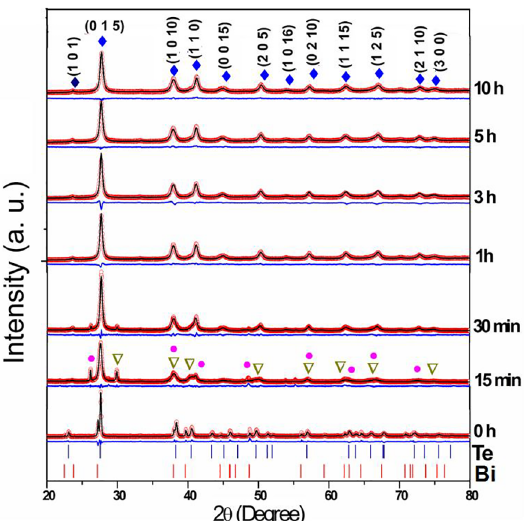
Figure 1. Rietveld output of X-ray powder diffraction patterns of ball-milled Bi-Te powder mixtures. Experimental data points are shown as hollow circles, while refined simulated patterns are shown as continuous lines. The difference between the experimental data (I ) and the fitted simulated pattern (I o line under respective diffraction pattern. Presence of BiTe (I) (●) and BiTe (II) ( ▽ ) in 15min milled sample is shown with different symbols. The peak positions of Bi and Te are shown as small solid bar markers at the bottom of the figure. Crystal planes of Bi indexed in XRD pattern of 10 h ball-milled powder.